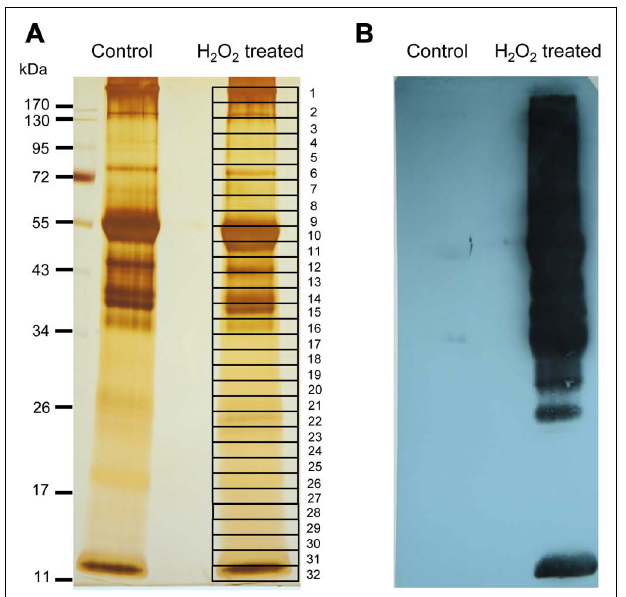
FIGURE 5 | Identification of early targets of H 2 O 2 -mediated protein oxidation. (A) Silver-stained SDS-PAGE gel showing the biotinylated proteins purified via streptavidin-agarose affinity column. Equal amounts of eluted protein were loaded from control and H 2 O 2 -treated samples. Band numbered on the gel corresponds to the excised gel sections which were trypsin-digested and analyzed by MALDI-TOF MS. Proteins identified with significant MASCOT score > 75 are shown in Table 1 . At least two peptides were identified per protein. (B) Western blot visualization of biotinylated proteins with anti-biotin antibody. Equal amounts of protein (100 μ g) were loaded in case of the untreated control and H 2 O 2 -treated samples.The result is representative of three independent